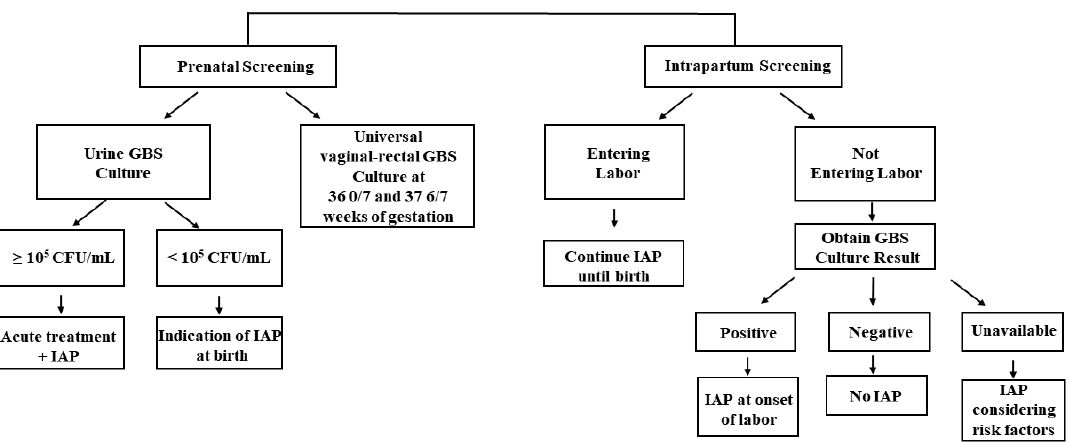
Figure 1. An overall schema of the CDC recommended IAP strategy for GBS screening and IAP administration